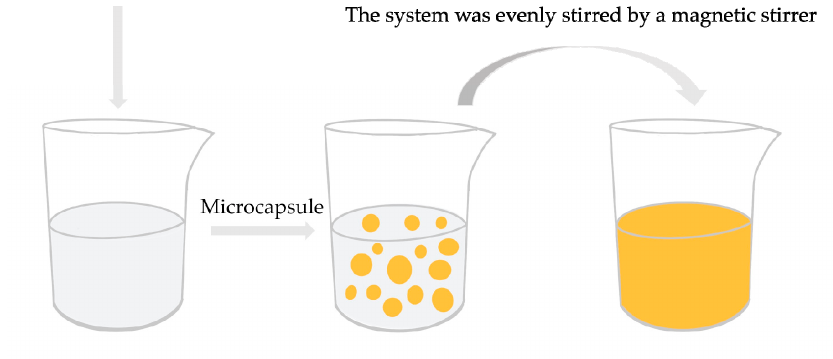
Figure 1. Fabrication process of waterborne coating added with thermochromic microcapsules.